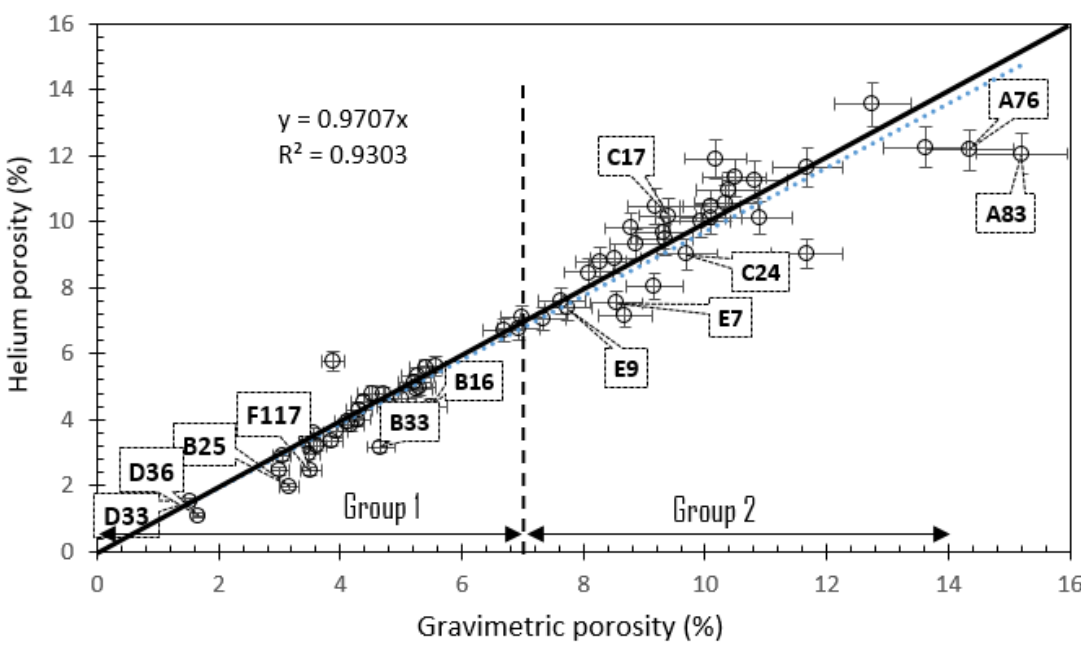
Figure 15. Cross-plot of helium porosity and gravimetric porosity for 56 subsamples.